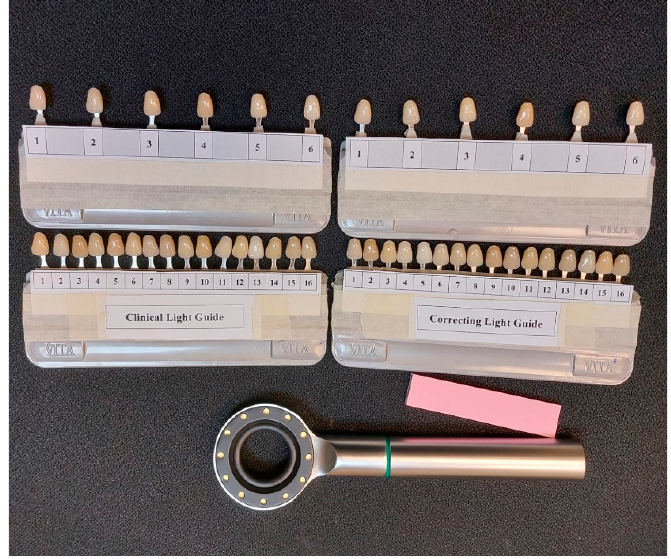
Figure 1. VITA Classical shade guides: Clinical Light Guide, and Correcting Light Guide .